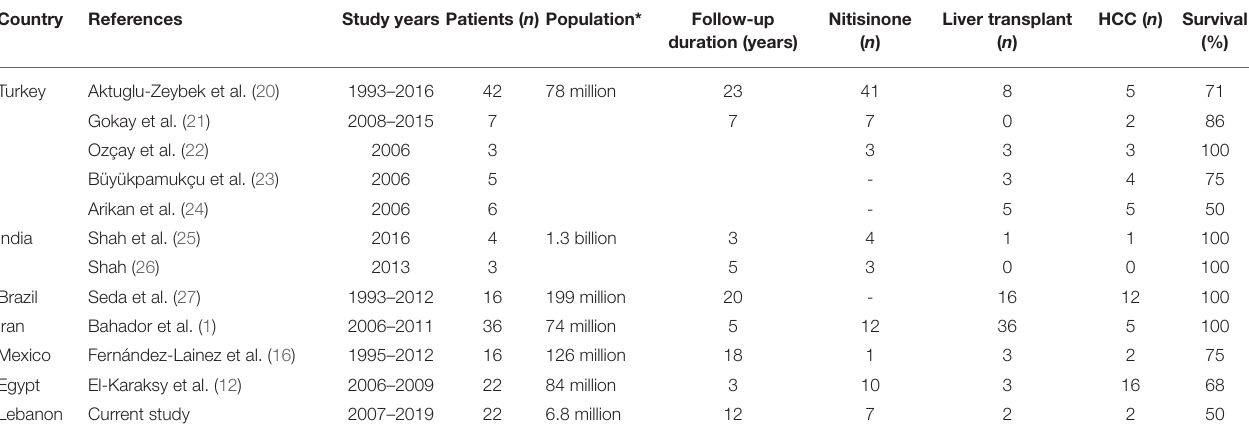
TABLE 3 | Outcome of hereditary tyrosinemia type 1 in developing countries. Country